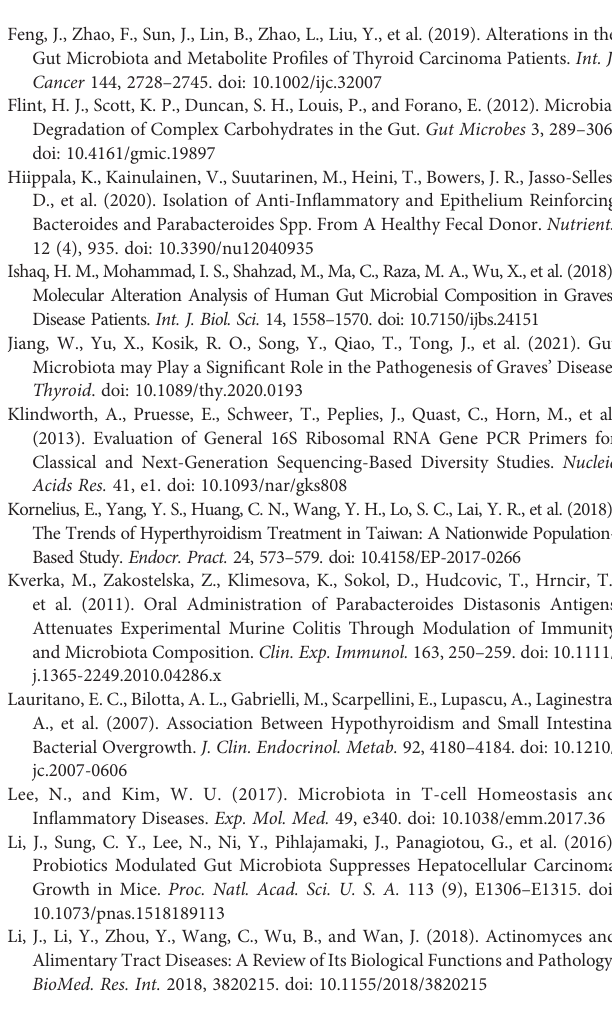
analysis. GD, Graves ’ disease; HC, healthy controls. Supplementary Figure 1 | Venn diagram illustrating the overlap of OTUs in the gut microbiota among the two groups Supplementary Figure 2 | Composition analysis of the gut microbiota at different taxonomic levels among the two groups: (A) phylum, (B) class, (C) order, (D) family, (E) genus. Only the top 10 most abundant OTUs are